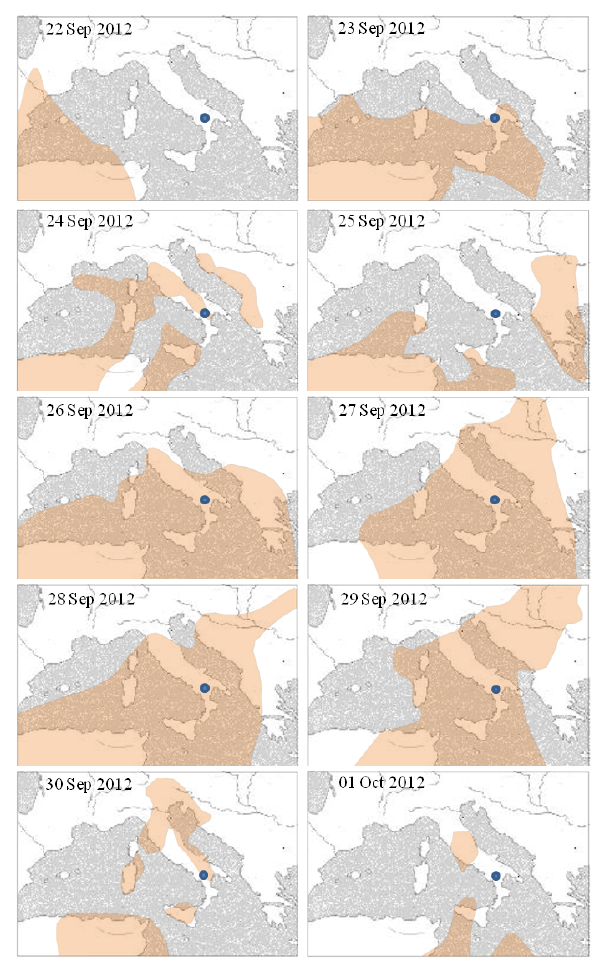
Figure 3. Sketch maps of the Mediterranean Basin highlighting ar- eas with dust surface concentrations ≥ 20µgm − 3 at 12:00Z, from NAAPS (Navy Aerosol Analysis and Prediction System) Archive of U.S. Naval Research Laboratory (http://www.nrlmry.navy.mil/ aerosol/),